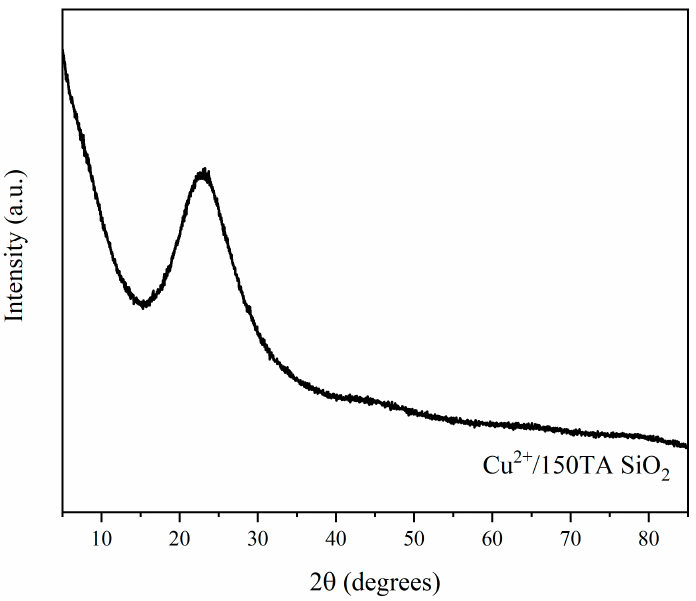
Figure 9. XRD diffractogram of 150TA-SiO 2 NPs after adsorption experiment with copper ion solu-